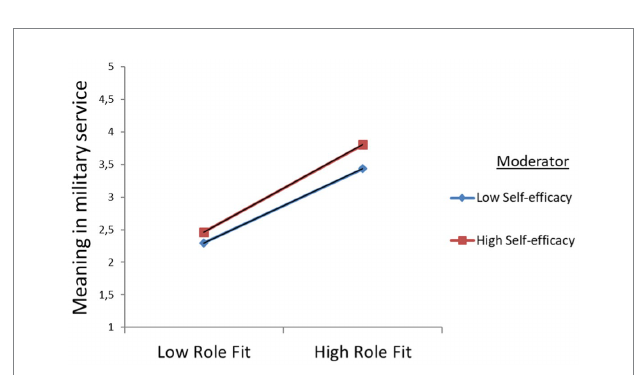
FIGURE 6 Graphical visualization of interactive effects for role fit and self-efficacy on meaning in military service at the beginning of military training (EMTM).